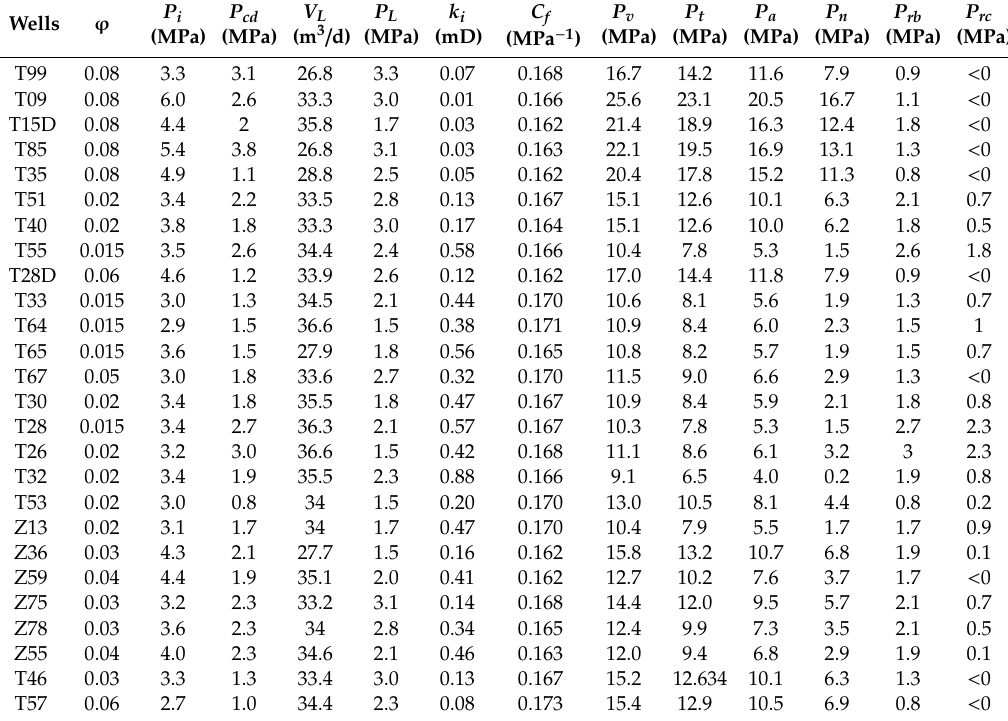
Table 6. Geological parameters and calculation results of the target wells in the Shizhuangnan